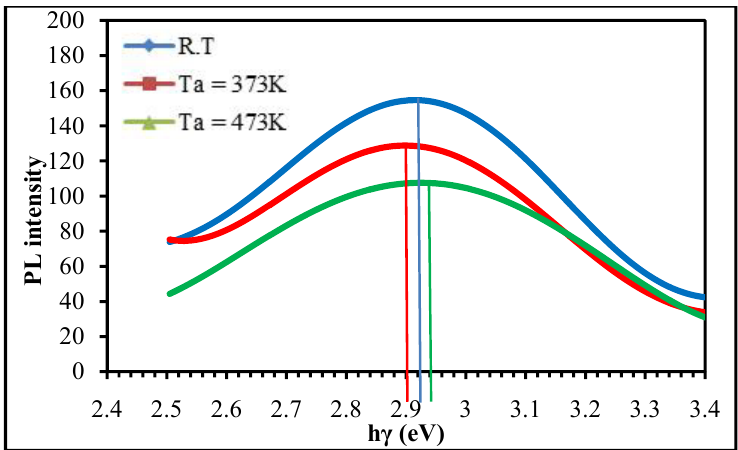
Fig. 8: Photoluminescence spectra of as-deposited and annealed NiPcTs thin films.